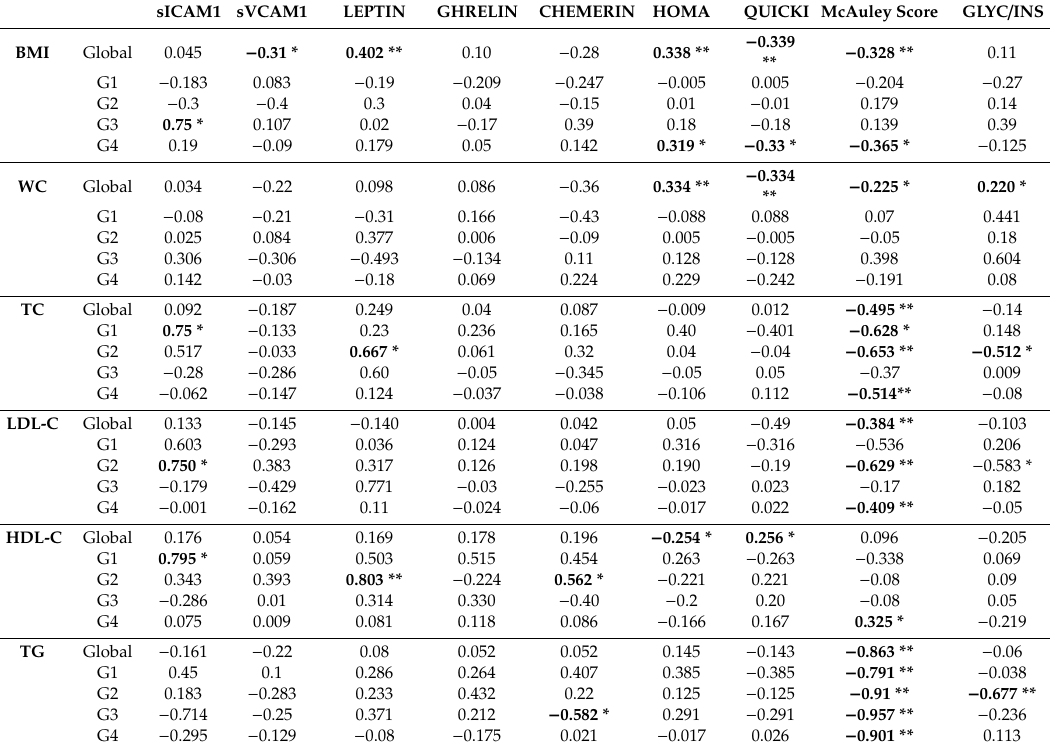
Table 4. Correlations between the parameters (at the global level and at a specific group